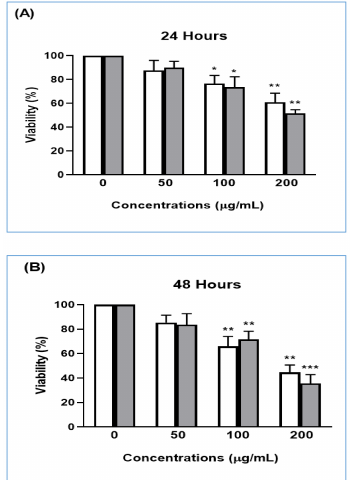
Figure 3. Anticancer e ff ect of T. polium methanolic extract on malignant Walker 256 / B mammary gland carcinoma cells (White) and MatLyLu prostate cancer cells (gray) in 24 ( A ) and 48 h ( B ). Legend: * p < 0.05, ** p < 0.01, *** p < 0.001. Table 5. Docking binding energies, conventional hydrogen bonding, and the number of closest residues to the docked compounds into the active site of human peroxiredoxin 5. Compound No. Class of Compounds